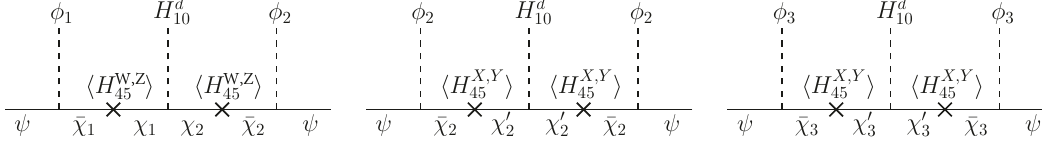
Figure 2. Diagrams coupling to H d Yukawa